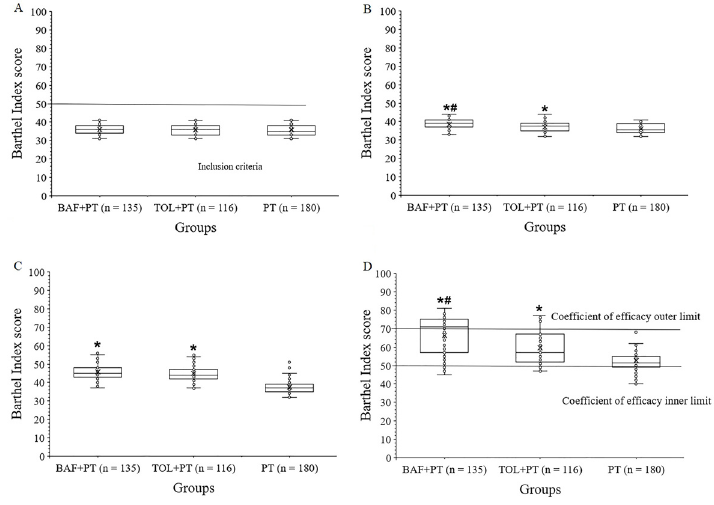
Figure 4. The Barthel Index score at different points of evaluation. A , Before the start of interventions. B , C , and D , at 2, 4, and 6 weeks after the start of interventions, respectively. Data are reported as medians and interquartile range. *P o 0.05 compared to the PT group; # P o 0.05 compared to TOL + PT group (ANOVA). BAF + PT: baclofen plus physical therapy; TOL + PT: tolperisone plus physical therapy; PT: physical therapy alone. A score of 0 indicates patient dependency and X 95 indicates patient